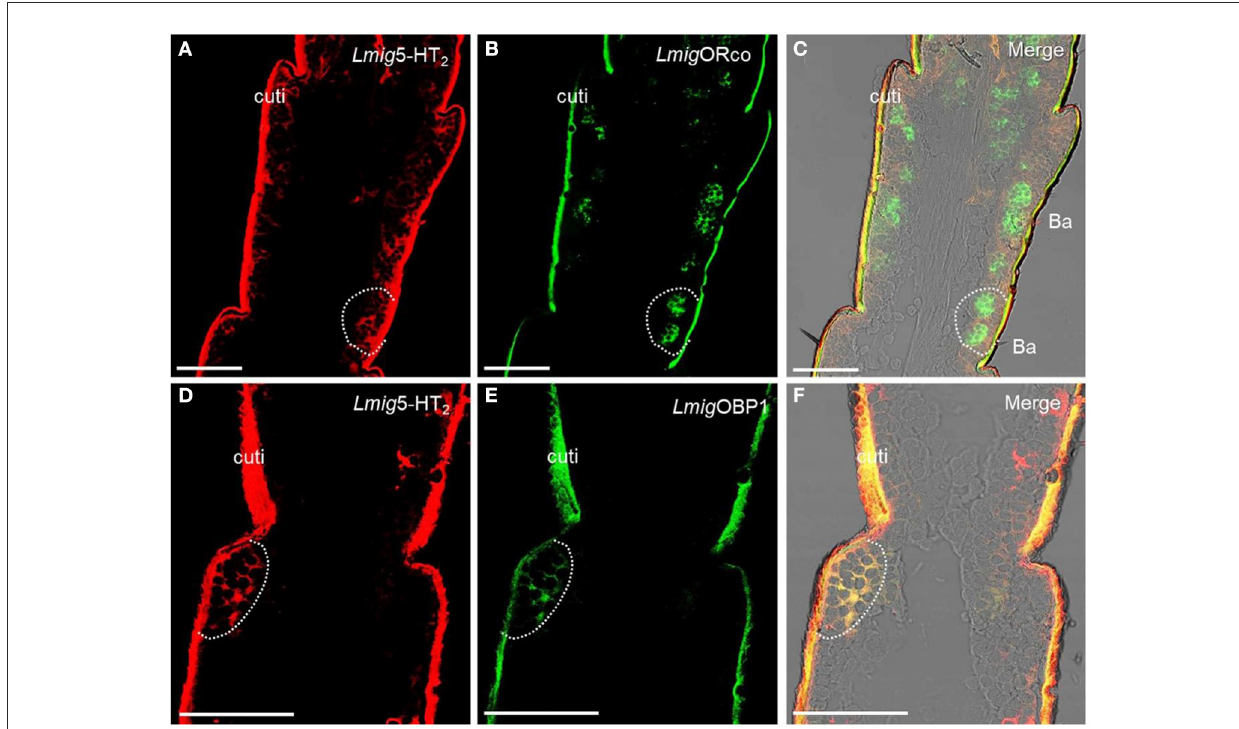
FIGURE3 Localization of Lmig 5-HT 2 by dual-color fluorescence in situ hybridization experiments in locust antennae. (A) Antennal cryosection stained by an antisense probe against 5-HT 2 RNA with DIG, red. (B) Antennal cryosection stained by an antisense probe against Lmig Orco RNA with BIO, green. (C) A and B merged with the brightfield image. (D) Antennal cryosection stained by an antisense probe against 5-HT 2 RNA with DIG, red. (E) Antennal cryosection stained by an antisense probe against Lmig OBP1 RNA with BIO, green. (F) D and E merged WITH the brightfield image. Cuti, cuticle. Scale bars: 100 µ